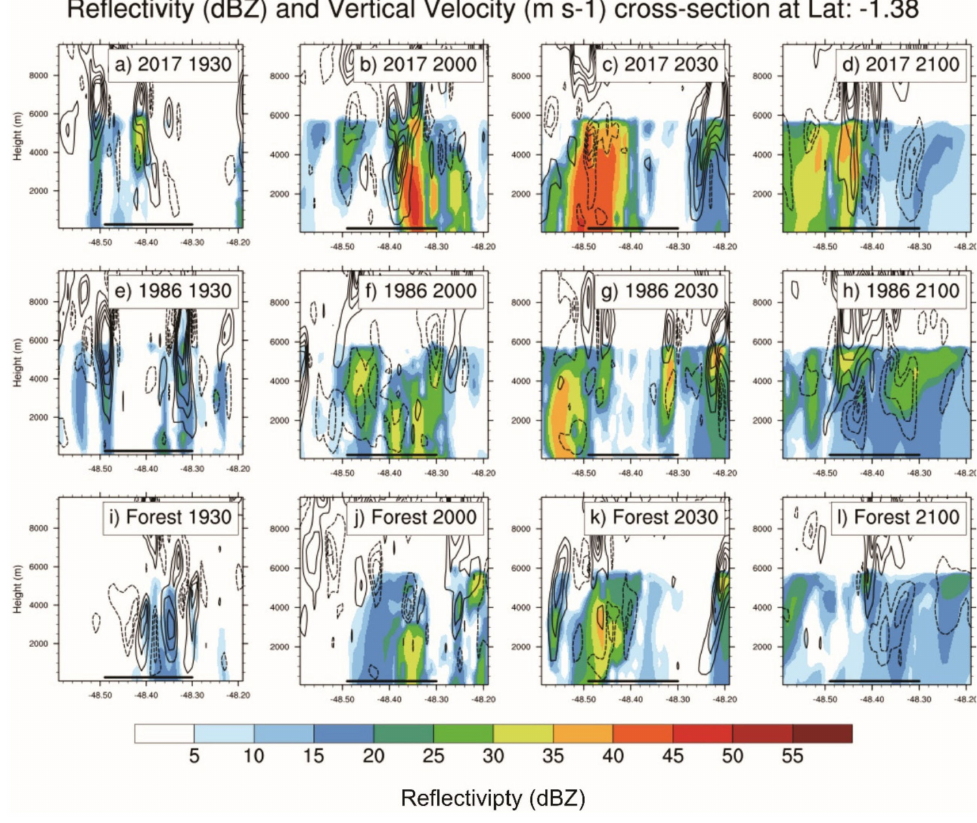
Figure 13. Reflectivity (dBZ) values for the 2017 ( a – d ), 1986 ( e – h ), and forest ( i – l ) scenarios at 1930, 2000, 2030, and 2100 UTC. The dashed contours are the negative vertical wind speed, and the solid contours are positive vertical wind velocity, ranging from − 5 to 5 m s − 1 and an increment of 1 m s − 1 . The black line near the x -axis represents the